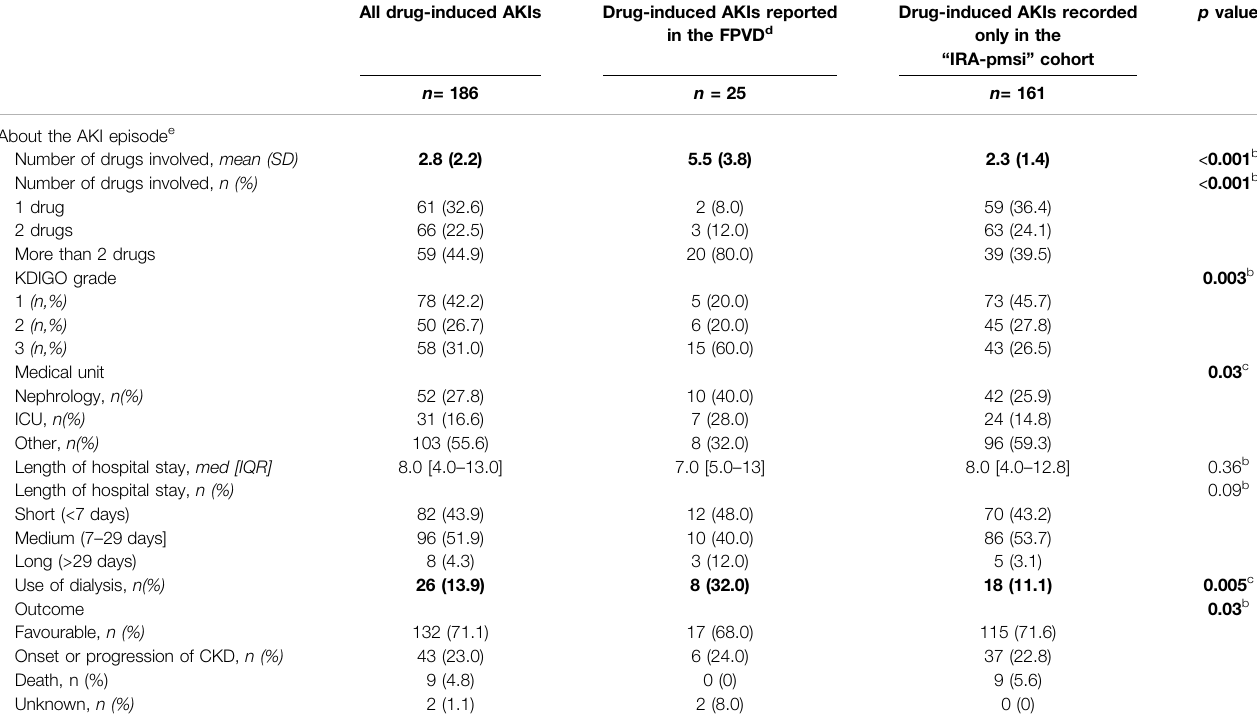
TABLE 4 | Characteristics of the episodes of community-acquired drug-induced AKI, by data source.